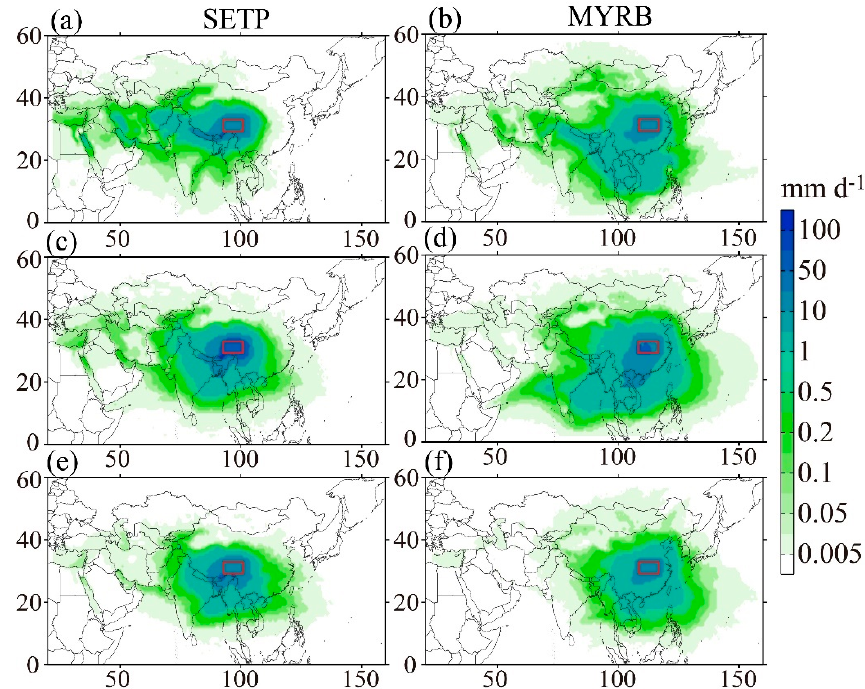
Figure 3. Monthly variations of evaporative sources (unit: mm d − 1 ) for the SETP (left) and the MYRB (right) in the wet season ( a , b ) April–May, ( c , d ) June–July, ( e , f ) August–September over 1982–2011. Red boxes represent the target regions. Table 2. Monthly and wet season (April–September) average terrestrial and oceanic evaporative sources contributing to precipitation (unit: %) in the SETP and MYRB over 1982–2011. The terrestrial source represents the evaporative source from the land area, which includes the local contribution from the target region (SETP or MYRB). The local contribution represents the local (SETP or MYRB) evaporative source contribution from the target region itself. The oceanic source contains evaporative sources from the Indian Ocean and Pacific Ocean. The contribution of the Indian Ocean consists of evaporative sources from BB and ARS, and the contribution of the Pacific Ocean consists of evaporative sources from SCS and PAC.